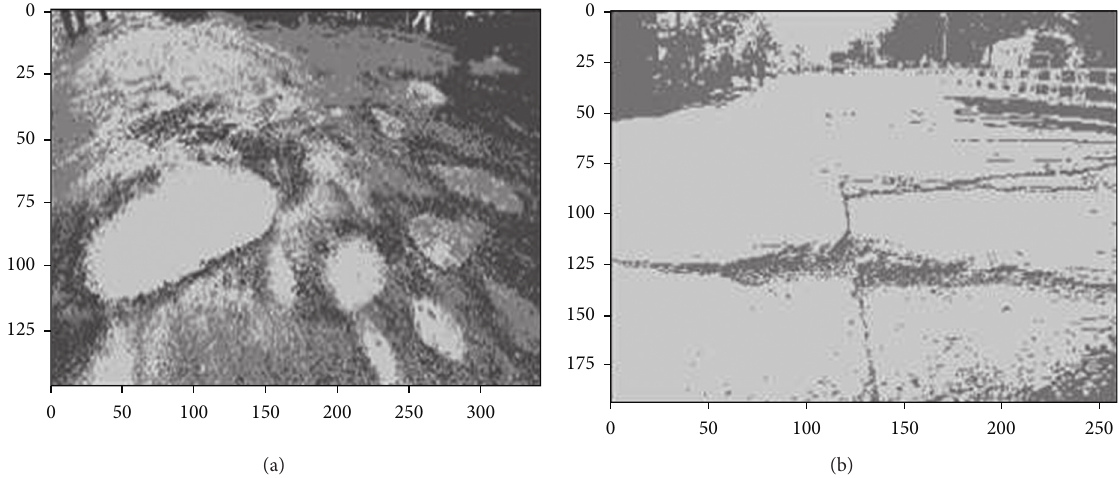
Figure 3: Pixel-based image segmentation of infrastructure images: (a) damaged roads and (b) cracked roads.